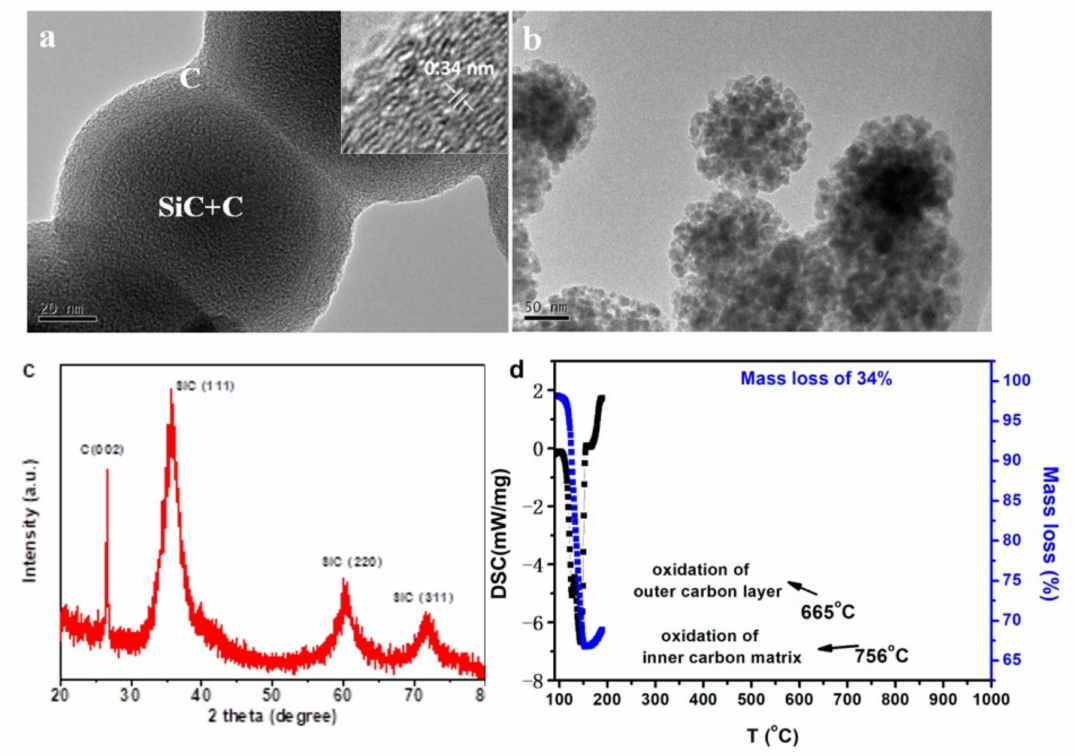
Figure 7. ( a ) TEM image of the SiC − C@graphene nanostructure (sample S6) and the inset shows the HRTEM image with a lattice distance of 0.34 nm for the outer carbon layer. ( b ) TEM image of the flower − like SiC nanoparticle assemblies after oxidation of the carbon phase. ( c ) XRD pattern of the SiC − C@graphene nanostructure after heat treatment at 1300 ◦ C. ( d ) TG − DSC curves for SiC − C@graphene nanostructure measured in air